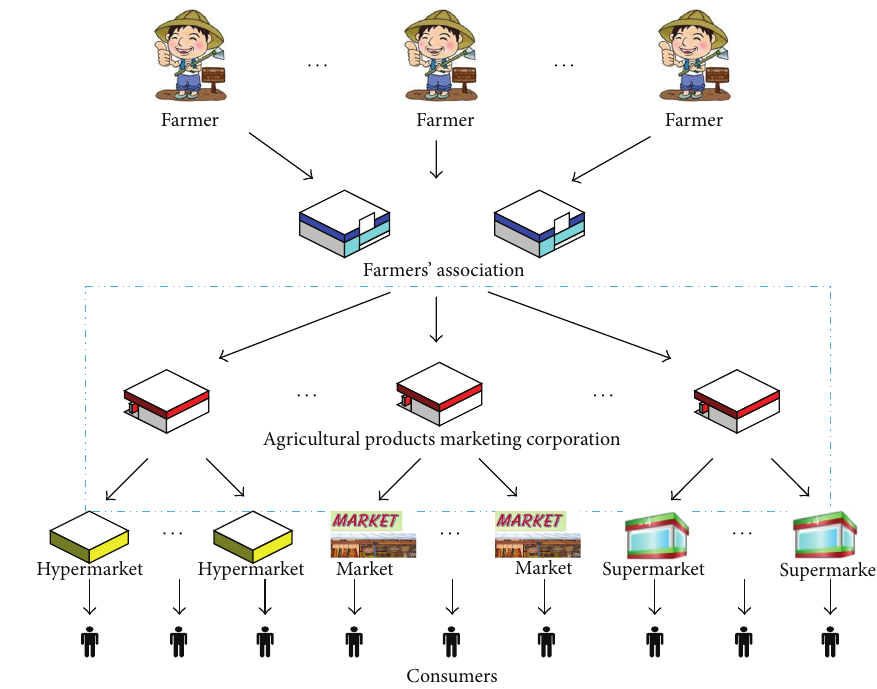
Figure 1: Agricultural product supply chain